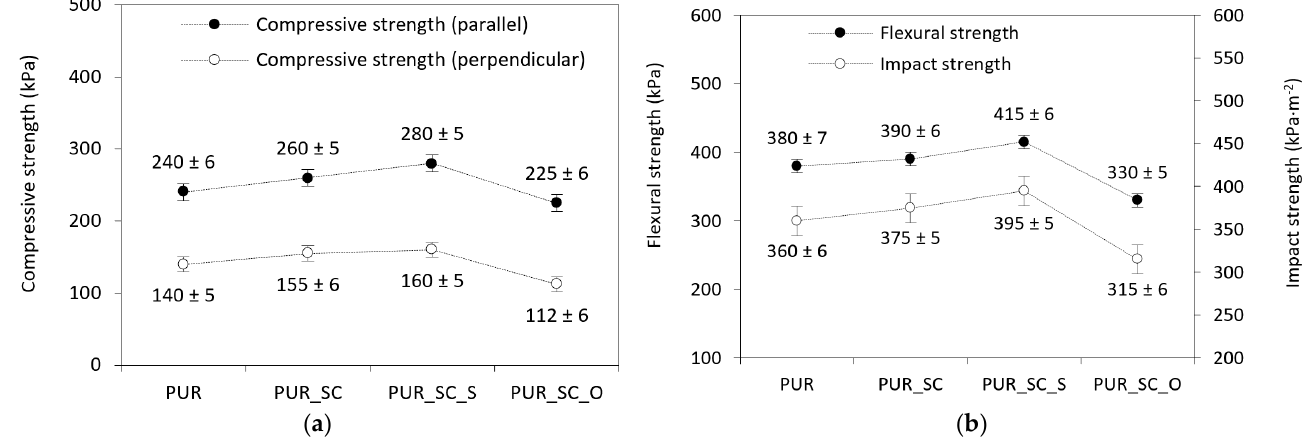
Figure 4. Impact of SC fillers on mechanical characteristics of PUR composites—( a ) compressive test, ( b ) three-point bending test and impact test.